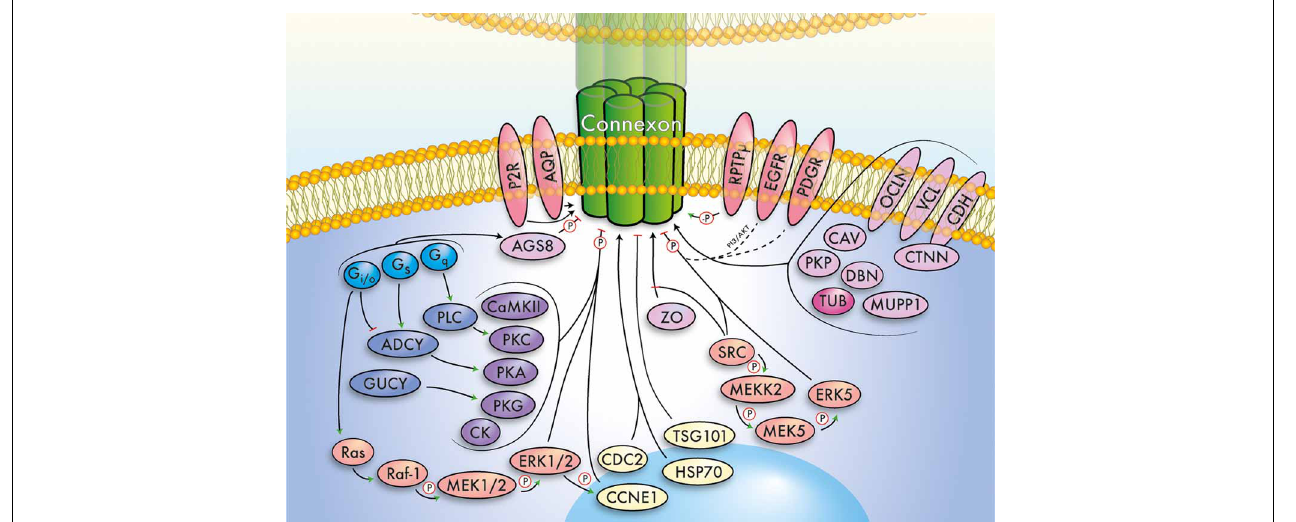
FIGURE 1 | Simplified summary of the gap junction network. This cartoon summarizes important signaling pathways, modulators, and interacting proteins of connexins, which converge exemplarily on a (green) connexin gap junction channel. The major functional groups outlined in the main text have been color-coded and relations between groups indicated by arrows. Further, phosphorylation (P) and